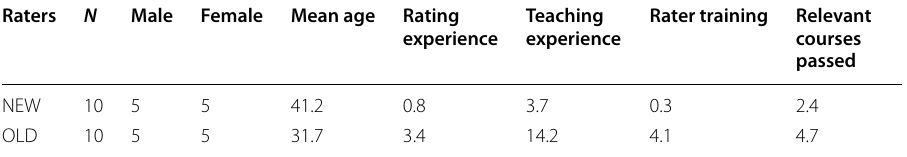
Table 3 Rater background